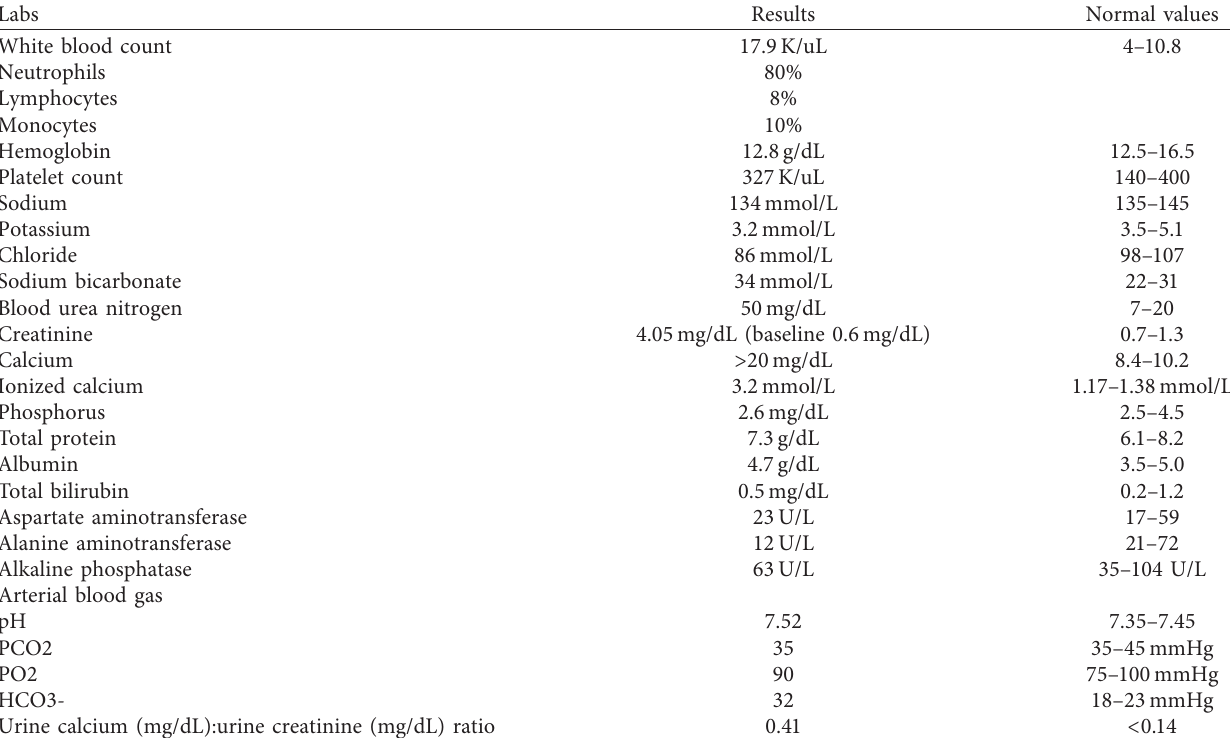
Table 1: Initial laboratory data.